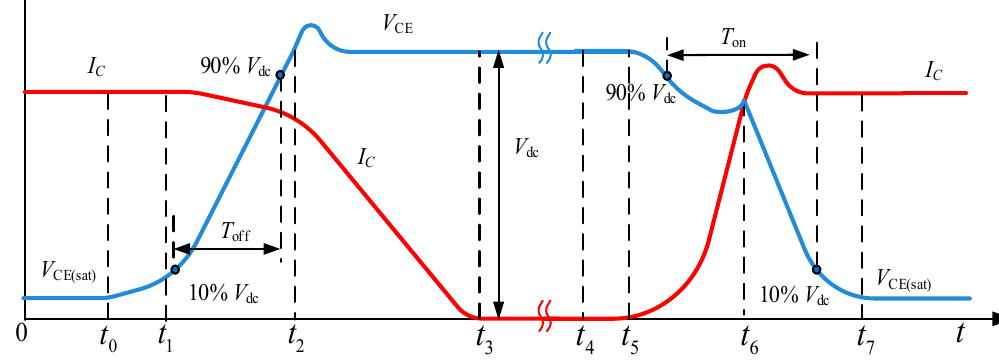
Figure 2. Waveforms of V CE and I C during IGBT switching transitions.